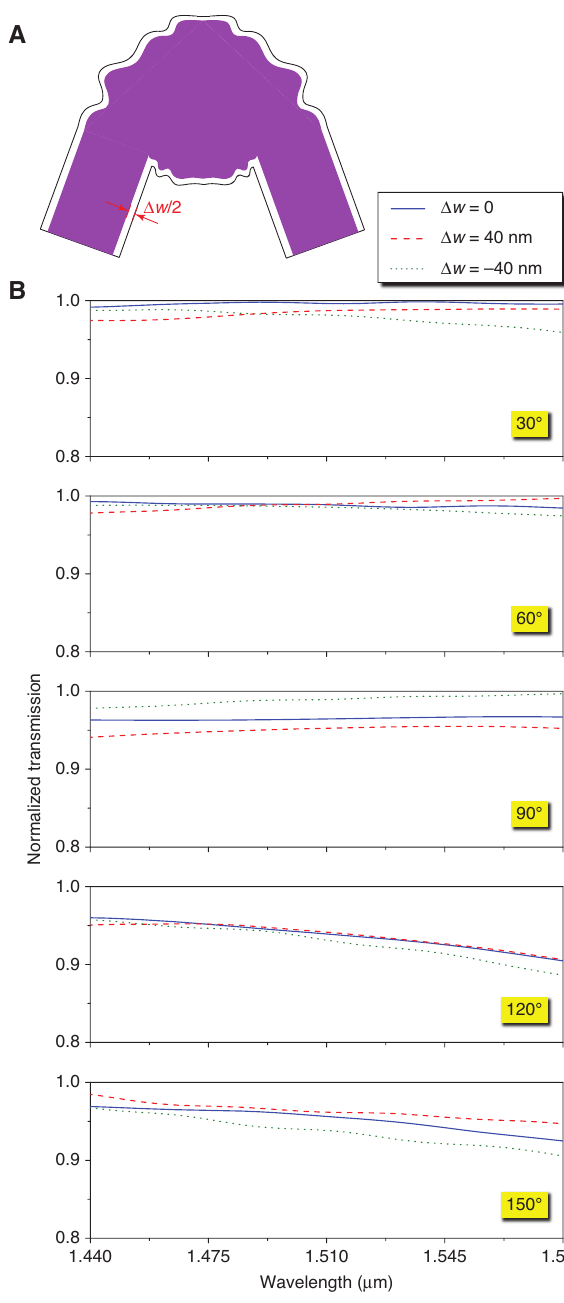
Figure 5: Fabrication tolerance analysis. (A) Illustration of a typical fabrication error of photonic welding points. The purple area denotes the fabricated structure, whereas the black solid line denotes the border of the original design. The width of the fabricated structure may have a deviation ∆ w from the designed value. (B) Analysis of the fabrication deviation in photonic welding points for connecting two waveguides with bending angles of 30 ° , 60 ° , 90 ° , 120 ° , and 150 ° . Blue solid, red dashed, and green dotted lines represent the ideal structure, the structure with width deviation ∆ w = 40 nm, and the structure with width deviation ∆ w = −40 nm, respectively.